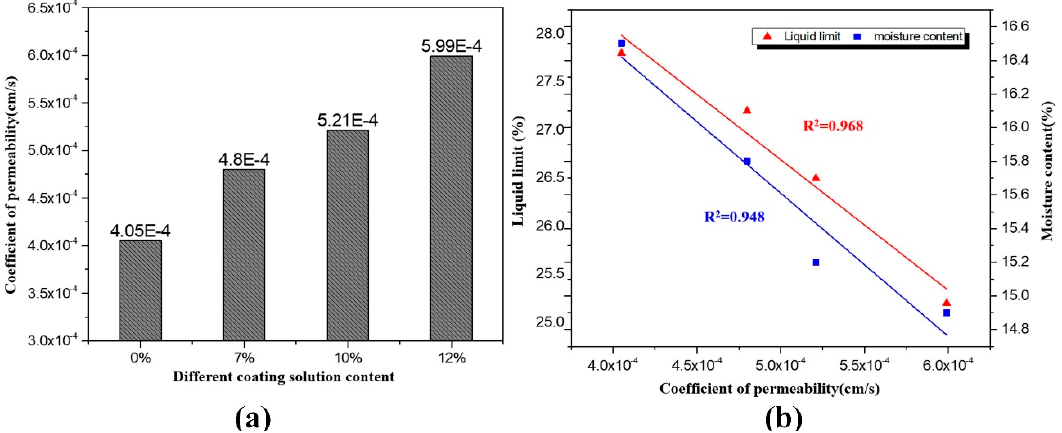
Figure 6. ( a ) Specific gravity and ( b ) moisture content of soil samples. Soil changes from solid state to semi-solid or plastic or fluid state due to the presence of moisture content. The liquid limit represents the boundary between the liquid state and the plastic state. The plastic limit represents the boundary between the plastic state and semi-solid state. Figure 7 displays the liquid limit and the plastic limit of the soil samples coated with different percentages of the coating solution. The results clearly demonstrate that liquid and plastic limit values tend to decrease when there is an increase in the amount of coating solution. For instance, a liquid limit value of 27.8%, 27.2%, 26.5%, and 25.2% was noted for the soil samples coated with 0%, 7%, 10%, and 12% coating solution, respectively. A plastic limit value of 14.5%, 13.9%, 12.9%, and 11.7% was measured for the samples coated with 0%, 7%, 10%, and 12% coating solution, respectively. This reduction in liquid limit and plastic limit values can be explained by the reduction in moisture content of the soil samples.